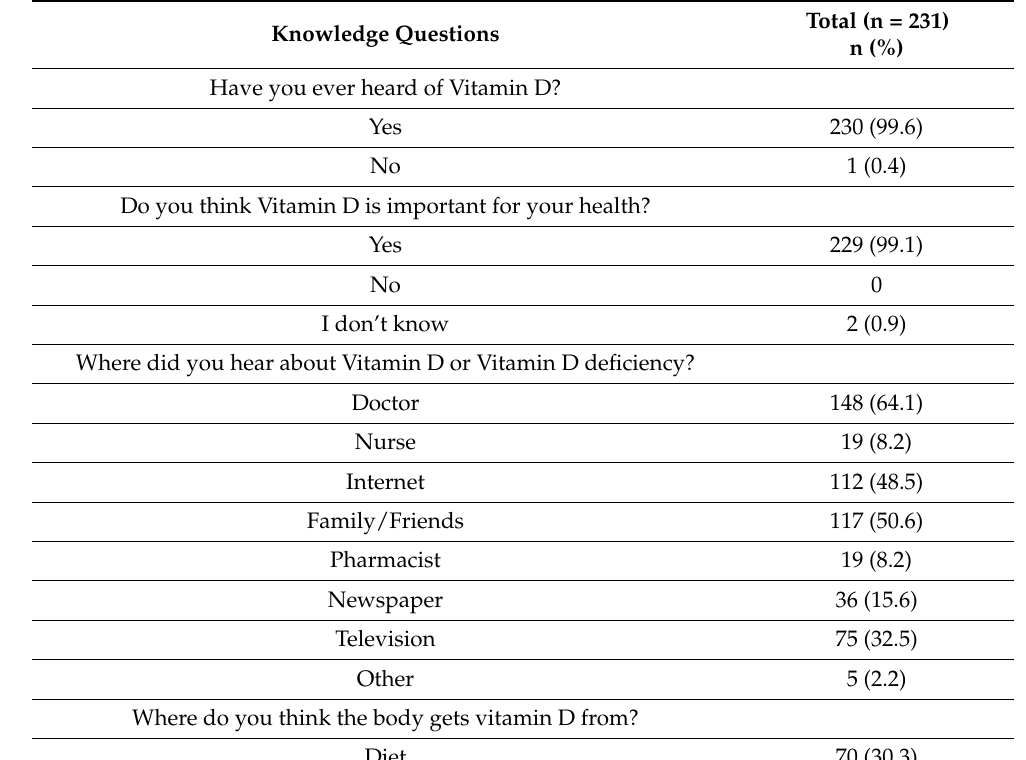
Table 2. Health educator’ knowledge regarding vitamin